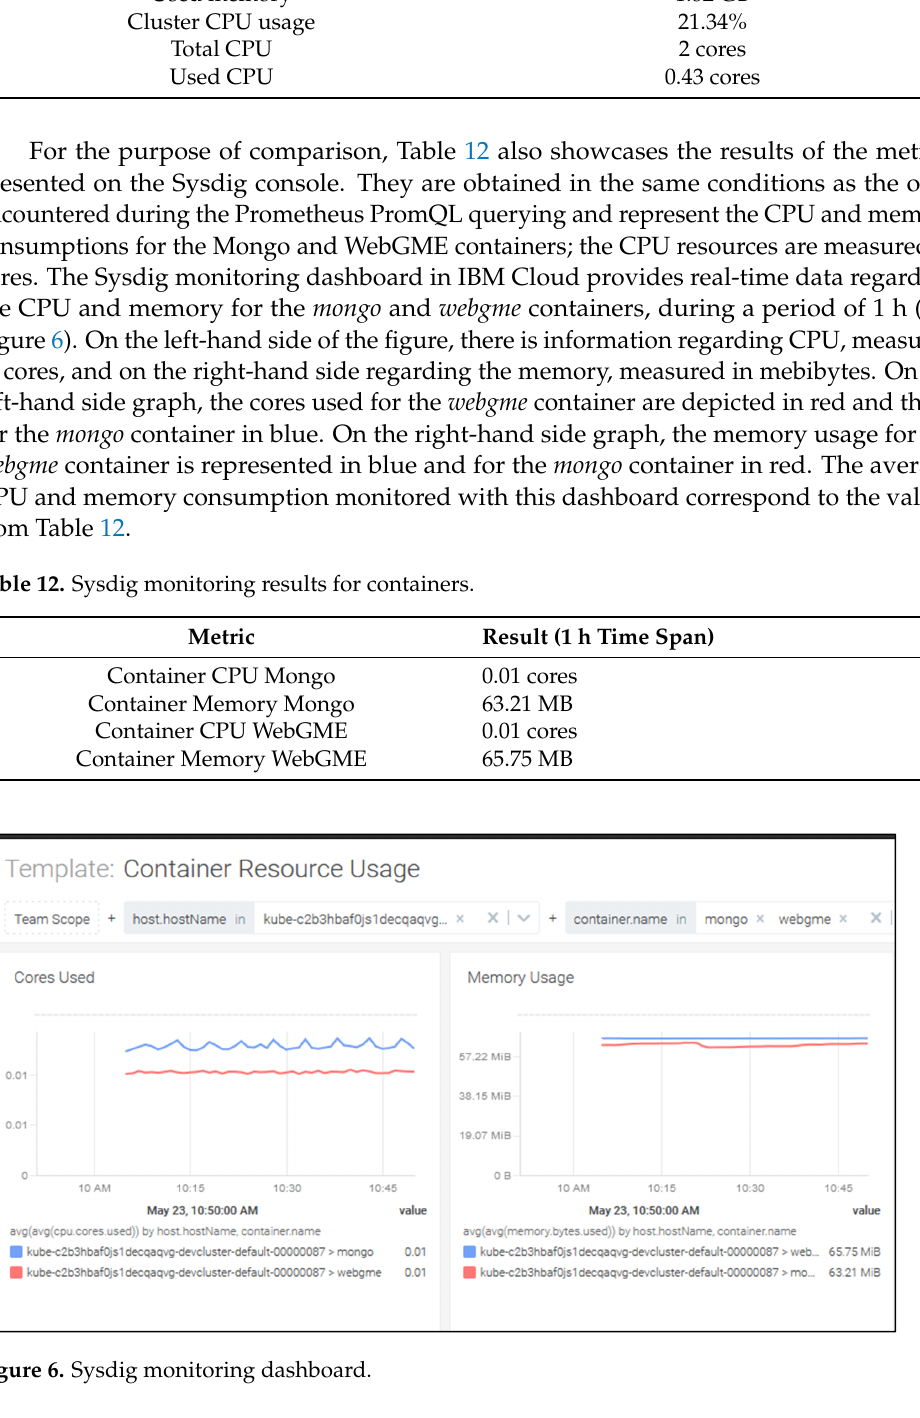
Table 13. Sysdig cluster metrics results.